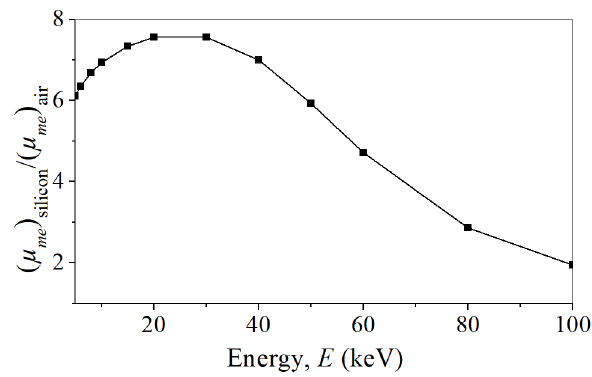
Figure 9. ( µ me ( E )) silicon /( µ me ( E )) air ratio versus X-ray photon energy.